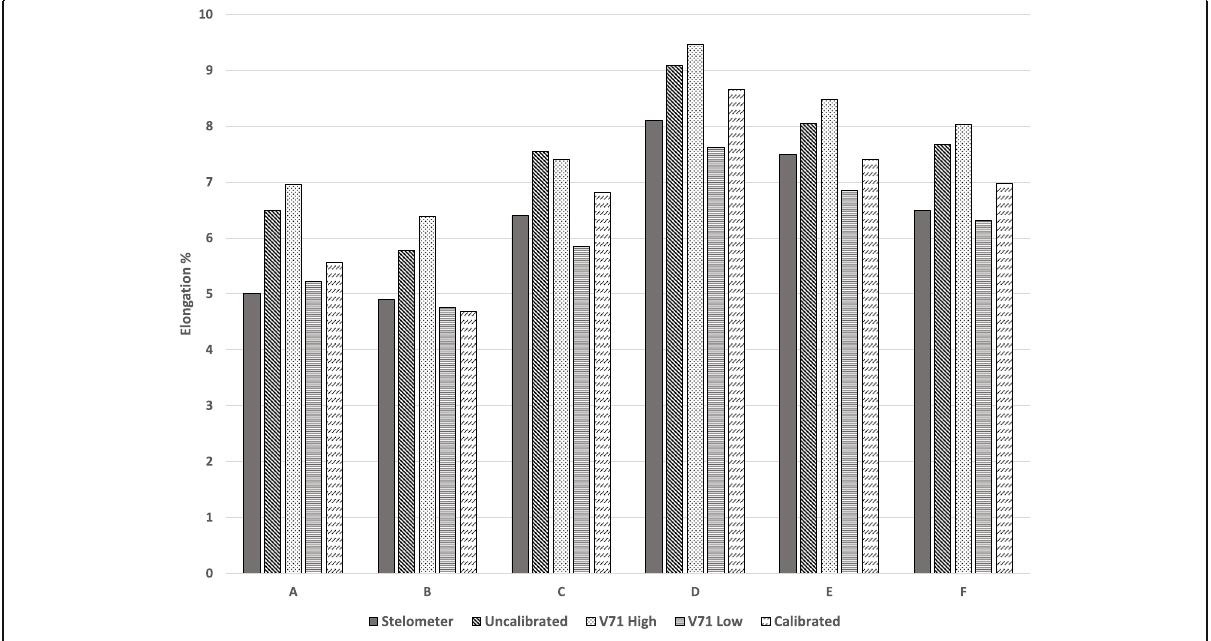
Fig. 1 Comparison of calibration techniques on a single